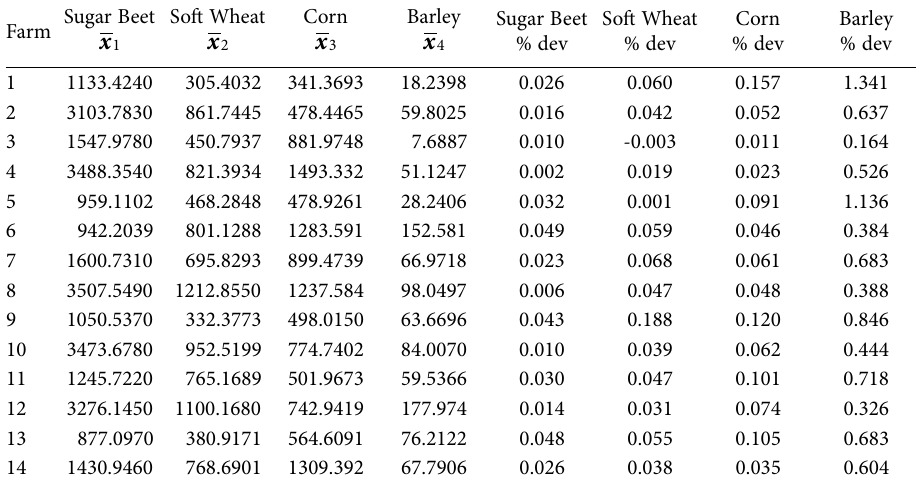
Table 1. Observed output levels, x and percent deviation (dev) of the LS calibrated solution, x ˆ.